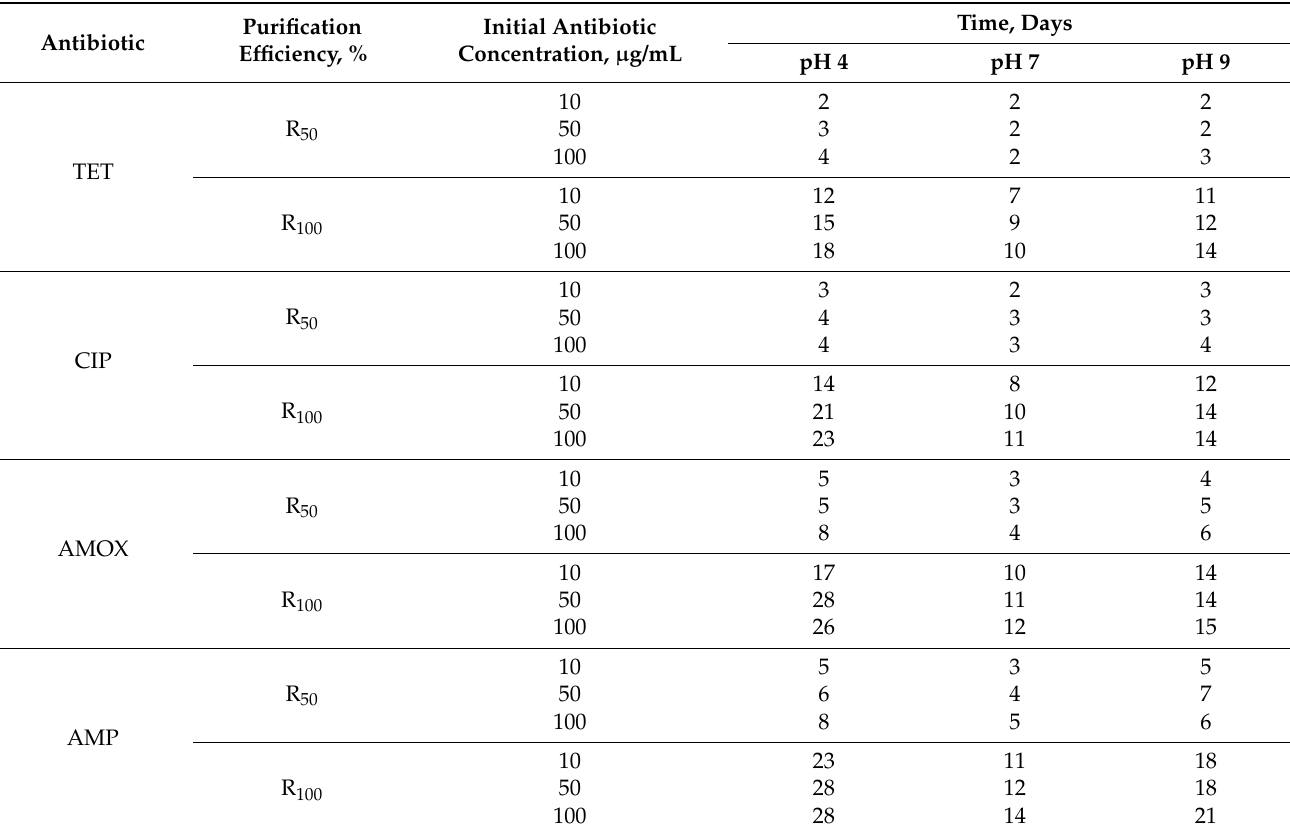
Table 1. Antibiotic purification efficiency using BN